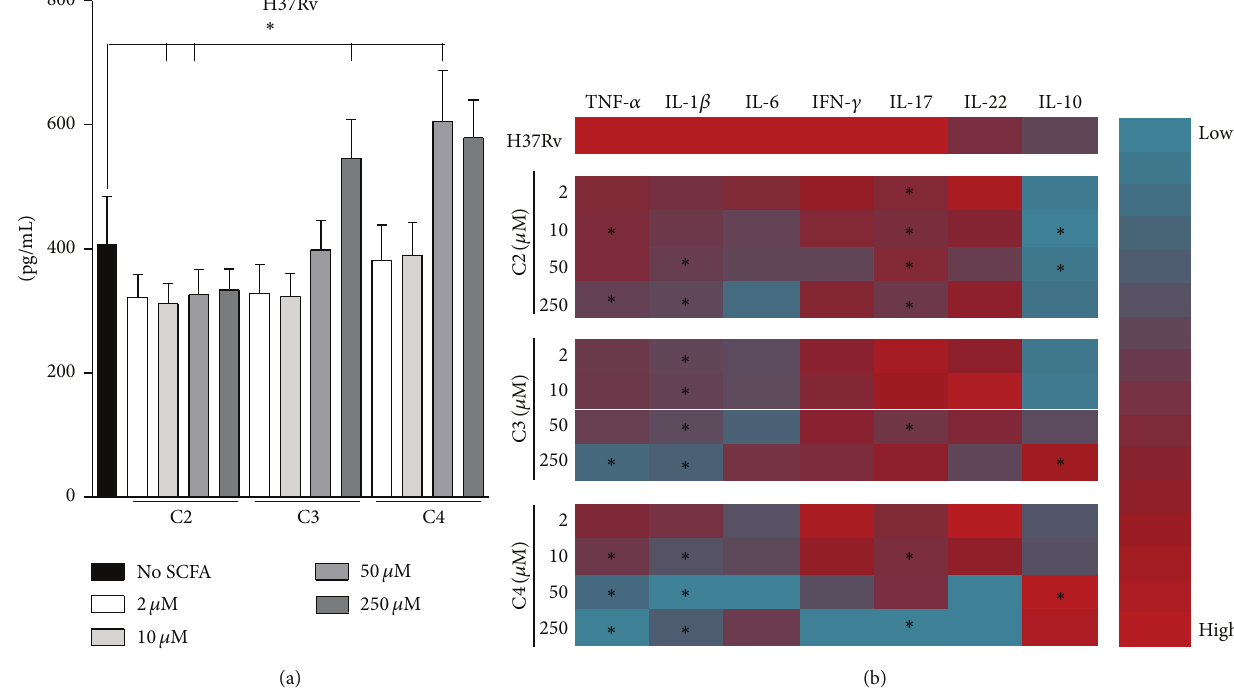
Figure 1: Short-chain fatty acids inhibit Mtb-induced cytokine responses. (a) PBMCs were preincubated with 2–250 𝜇 M SCFAs for 1h prior to stimulation with Mtb lysate for 24 h and 7d. Hereafter TNF- 𝛼 , IL-6, IL-10, IFN- 𝛾 , IL-17, and IL-22 were measured in supernatants by ELISA. Data are means ± SEM ( 𝑛 = 6 ), using Wilcoxon signed-rank test, representative of 2 independent experiments. ∗ 𝑝 < 0.05 . (b) Heat map of log-transformed mean cytokine responses as measured by ELISA, showing cytokines upregulated (red) and downregulated (blue) upon H37Rv stimulation in the presence of different doses of SCFAs. Cytokine responses are shown as compared to H37Rv stimulation alone. ∗ 𝑝 < 0.05